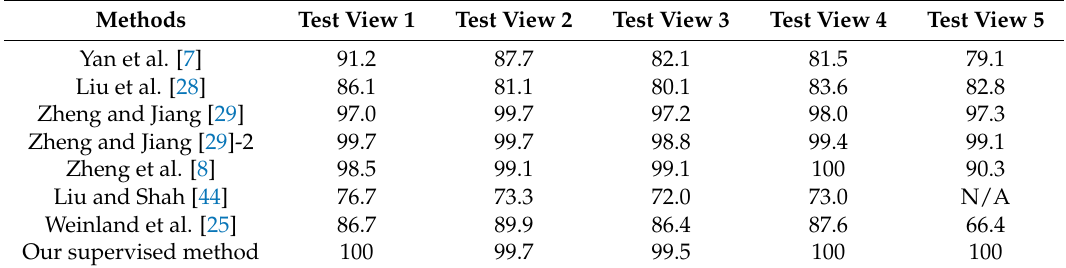
Table 4. Many-to-one cross-view action recognition results on the IXMAS dataset, where each column corresponds to a test